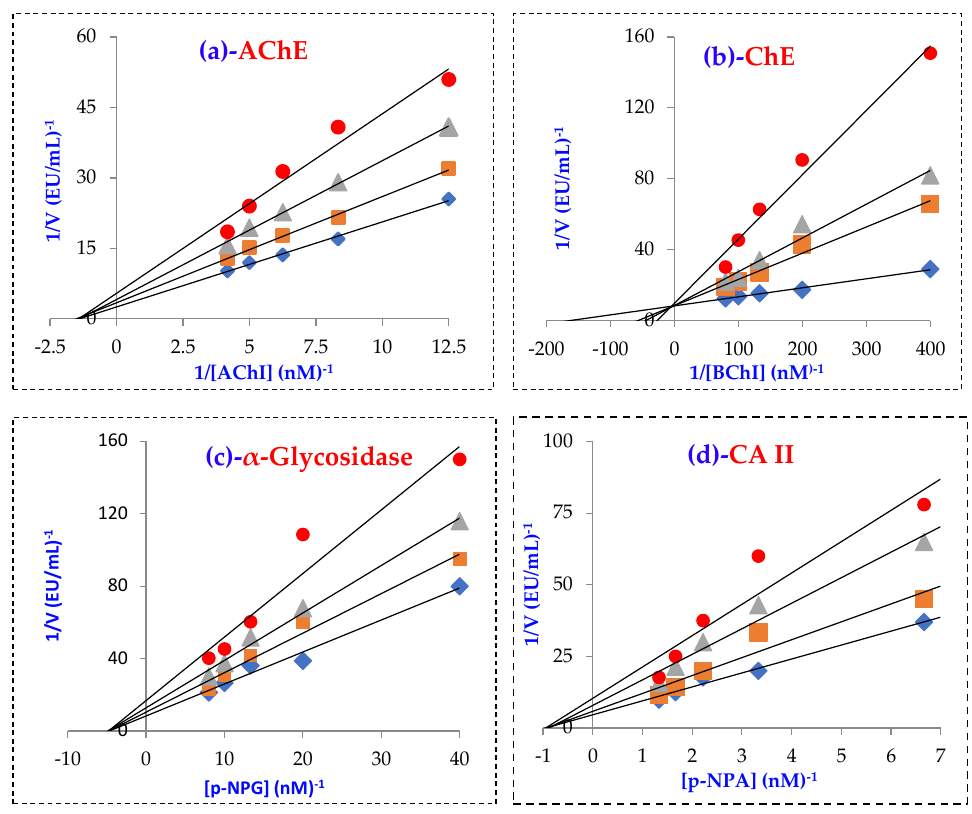
Figure 3. Lineweaver–Burk graphs of Magnofluorine towards acetylcholinesterase (AChE) enzyme ( a ), butyrylcholinesterase (BChE) enzyme ( b ), carbonic anhydrase II isoenzyme (CA II) ( c ), and α -glycosidase ( d ).